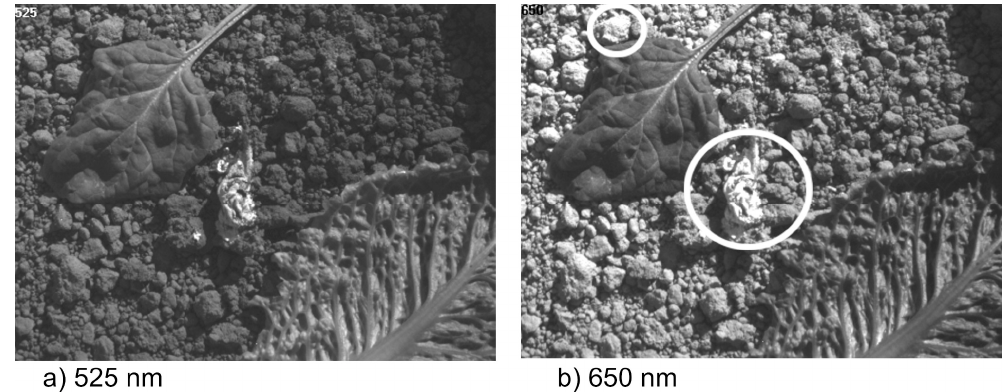
Figure 9. Reflectance images of a gull dropping at ( a ) 525 nm and ( b ) 650 nm. Note that the brightest areas of the circled dirt clod and dropping in the 650-nm image were both saturated; however, the larger relative extent of the saturated area for the dropping suggested that the dropping was brighter at its maximum than the dirt clod.